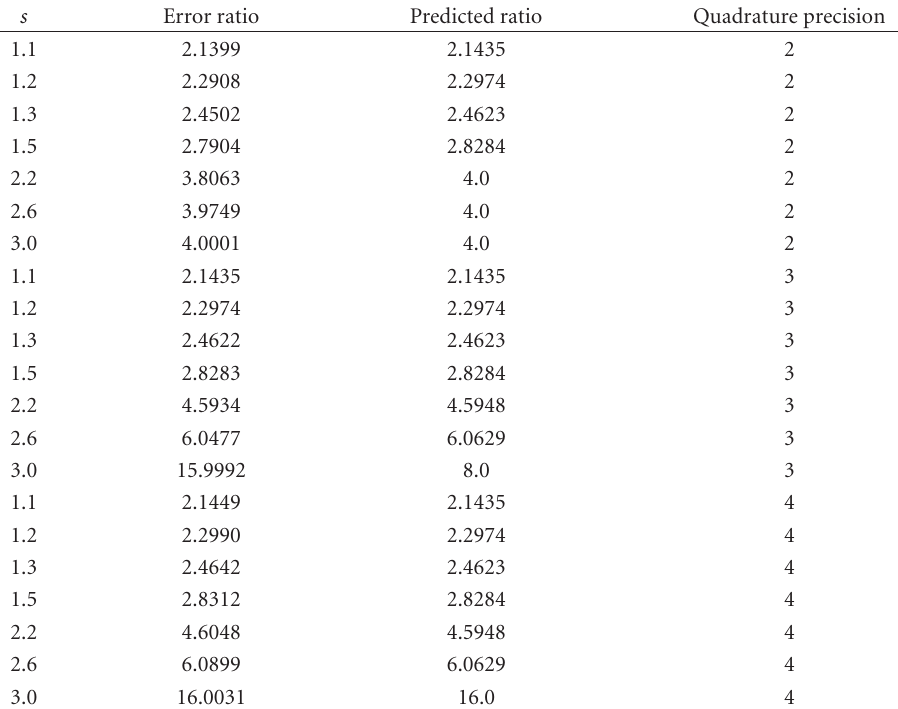
(cid:15) 1 on G 1